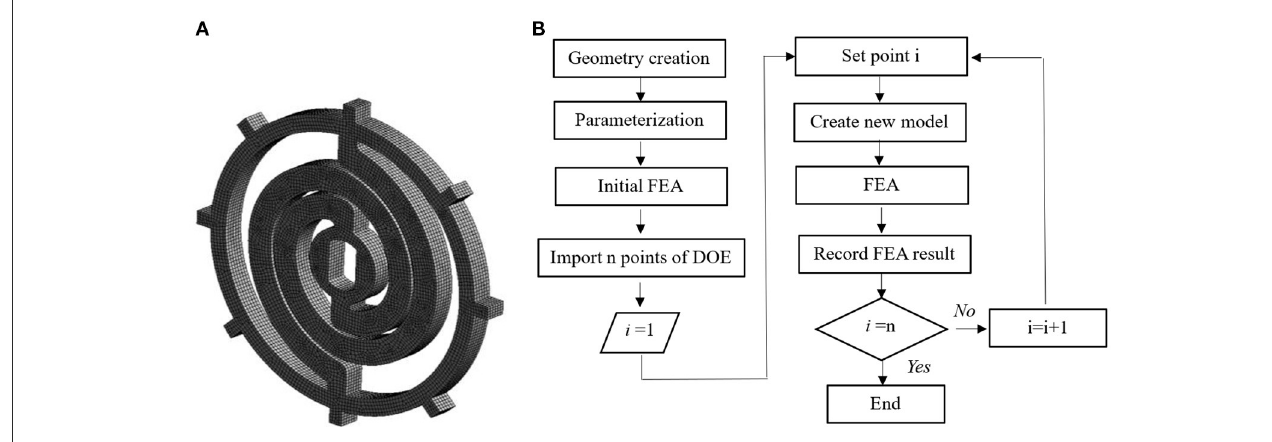
FIGURE3 The mesh created and flow chart for the finite element analysis (FEA) of the flexible coupler. (A) Mesh created. (B) Flow chart.